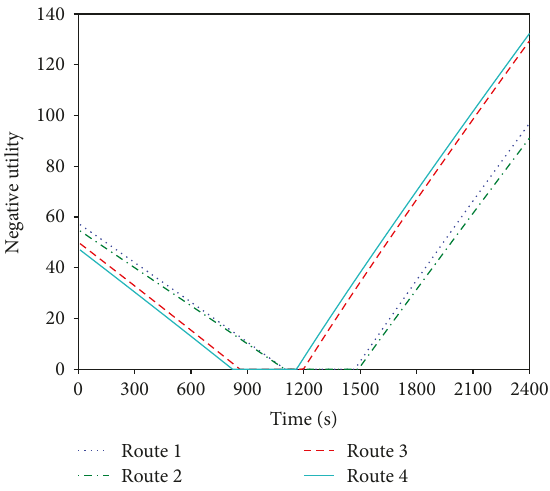
Figure 9: The relationship between departure time and negative utility of early/late arrival.